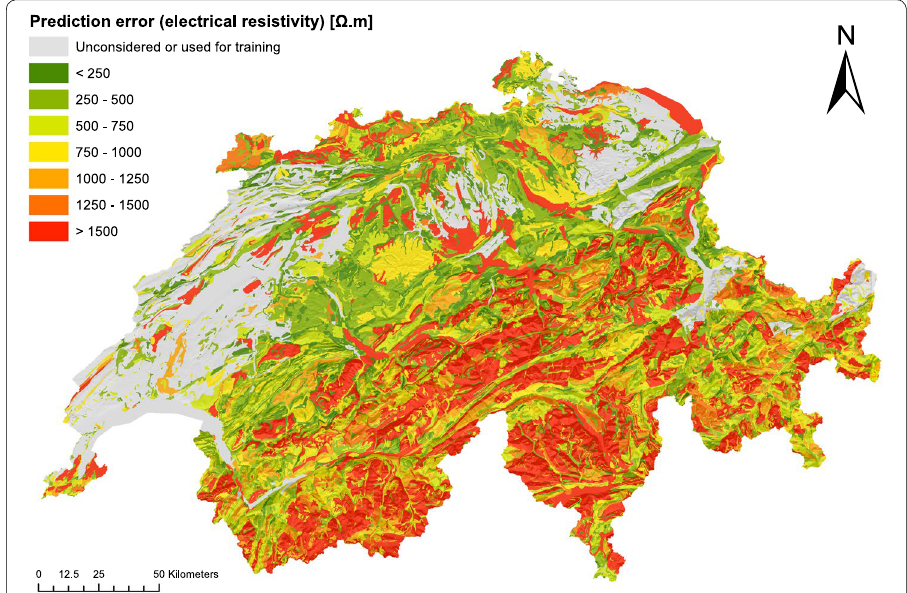
Fig. 12 Prediction error attached to the electrical resistivity estimation (for each GK500 polygon). The error is computed as the average of the lower and upper ( PE s,down and PE s,up ) width of Prediction Intervals computed with Quantile Regression